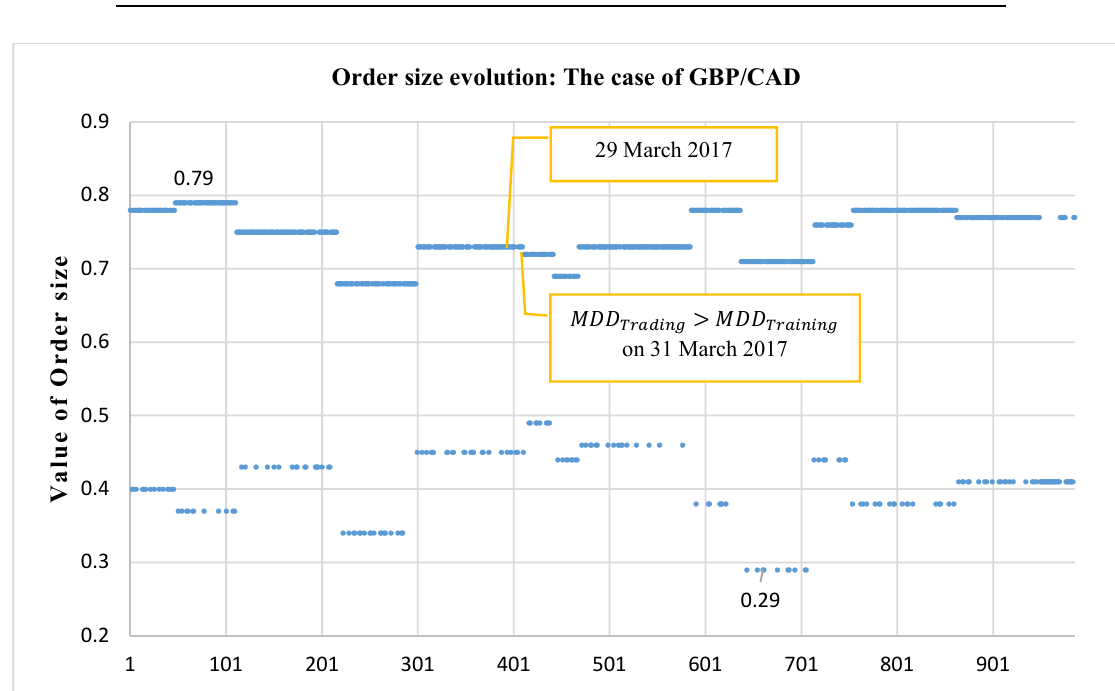
Figure 10. A scatter plot of the order size parameters PPV and FNR (i.e., the fraction of capital for a buy order) in the case of trading with IDBA over GBP/CAD. In this case, IDBA has triggered 986 trades in total (see Table 7). The x -axis denotes the indices of these trades. The y -axis denotes the order size (i.e., the fraction of capital used for a specific trade).